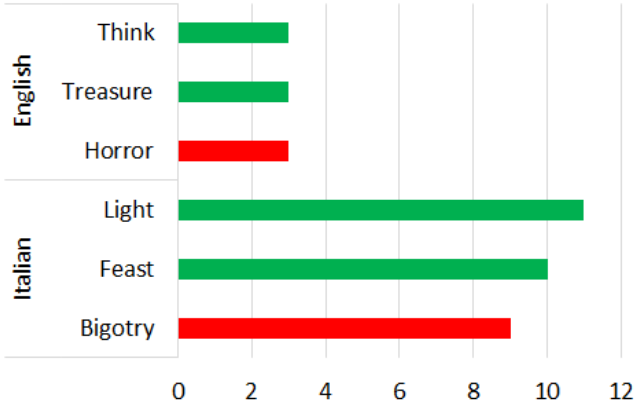
Figure 8. Rating of the most-cited words in English and Italian during phase 1 of COVID-19 pandemic (green is positive, red is negative).